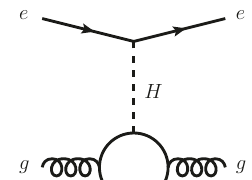
Figure 2 . One-loop level contribution to the CP-odd electron-gluon interaction in extended Higgs models with nonstandard Yukawa interactions. The external gluons are integrated out to give the S-PS e-N